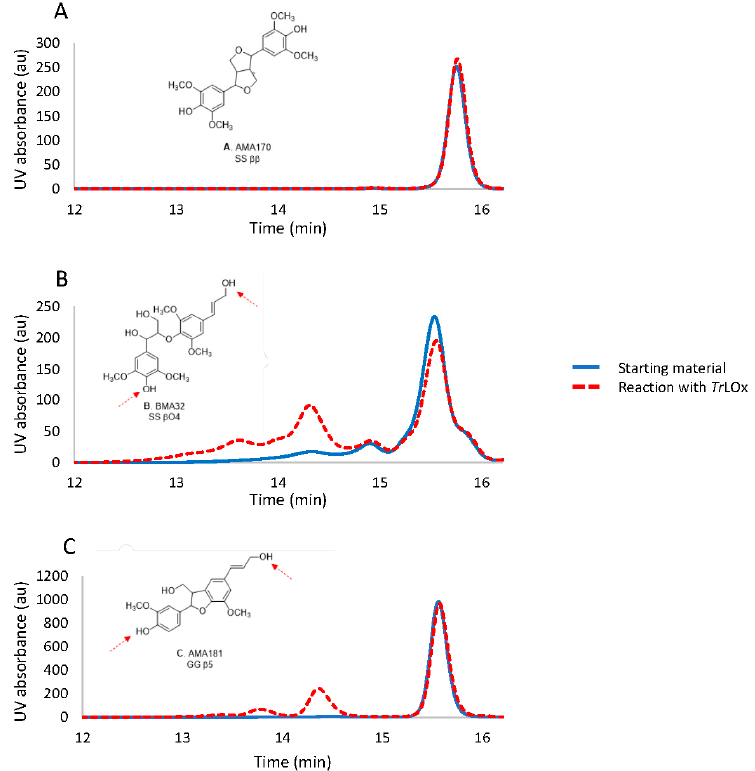
Figure 7. HPSEC-PDA (size-exclusion chromatography coupled to a photodiode array detector, absorbance 280 nm) profiles of the starting dimer and their reactions with Tr LOx, reaction with ( A ) AMA170, ( B ) BMA32 ( C ) AMA181; starting material (blue); reaction with Tr LOx (red). The red arrows indicate the potential coupling site by the action of Tr LOx.